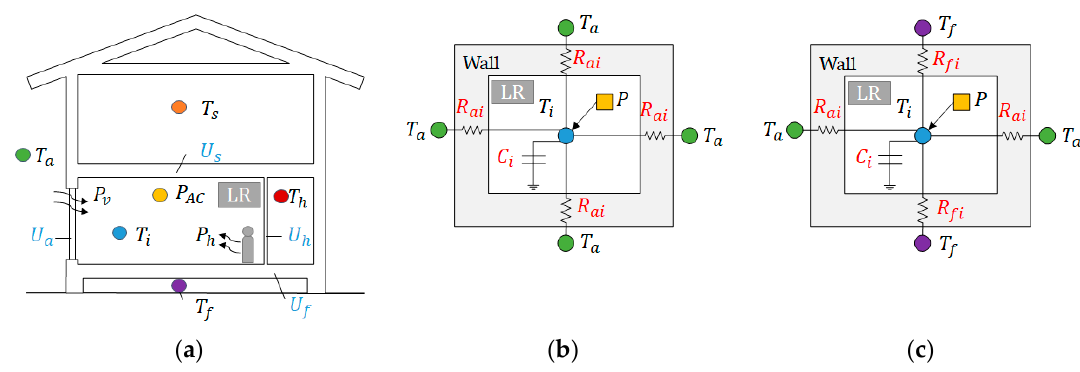
Figure 2. ( a ) Heat exchange for the living room (LR), ( b ) one-room model, ( c ) two-room model, where the measured inputs by sensors, ( T i , T a , T s , T f , T h , and P AC ) are represented in circles, total heat supply to the living room ( P ) are in a square, unknown parameters of heat capacity ( C i ) and thermal resistances ( R ai and R fi ) are in red texts, and heat transfer coe ffi cients ( U a , U s , U f , and U h ) derived from estimated parameters are in blue texts.